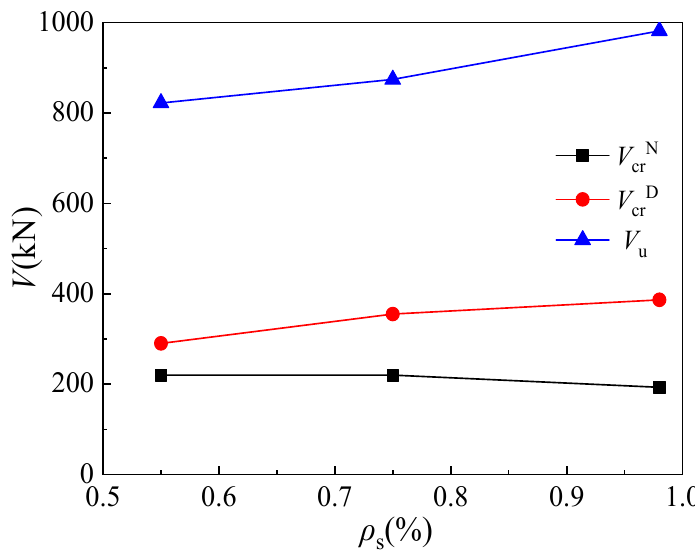
Figure 11. Relationship between load and longitudinal reinforcement ratio.